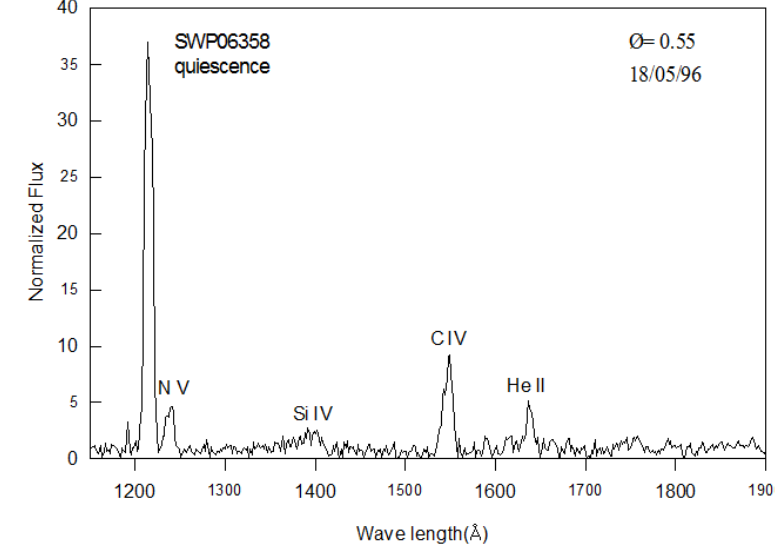
Fig. 3 IUE spectrum of DQ Her with quiescence flux at phase 0.55.